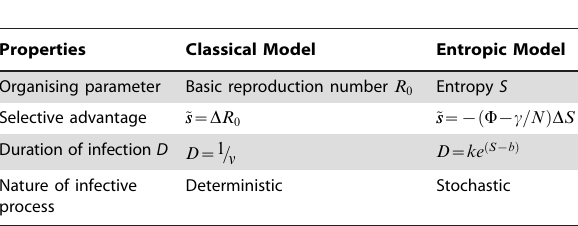
Table 2. Contrasting properties of conventional and entropic epidemic